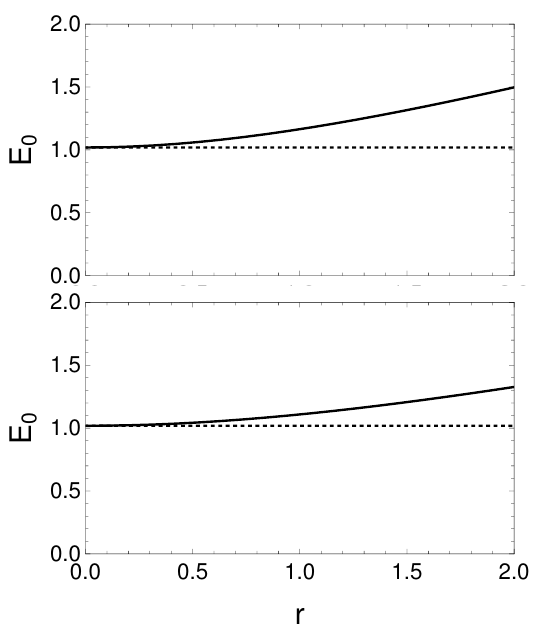
Figure 3 . Dependence of E 0 on r calculated for the quantum mechanical system with linear poten- tial regularized using a quadratic polynomial (2.5) with u = 1 (top) and a quartic polynomial (2.6) with u = 1 (bottom). The dotted lines indicate the results obtained from the analytic solutions for the original ( r → 0 ) potential